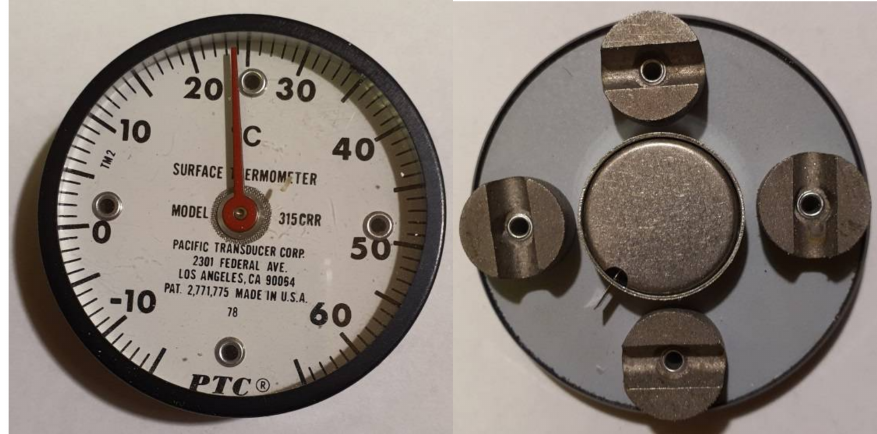
Figure 9. Rail temperature thermometer (source: photo made by Jacek